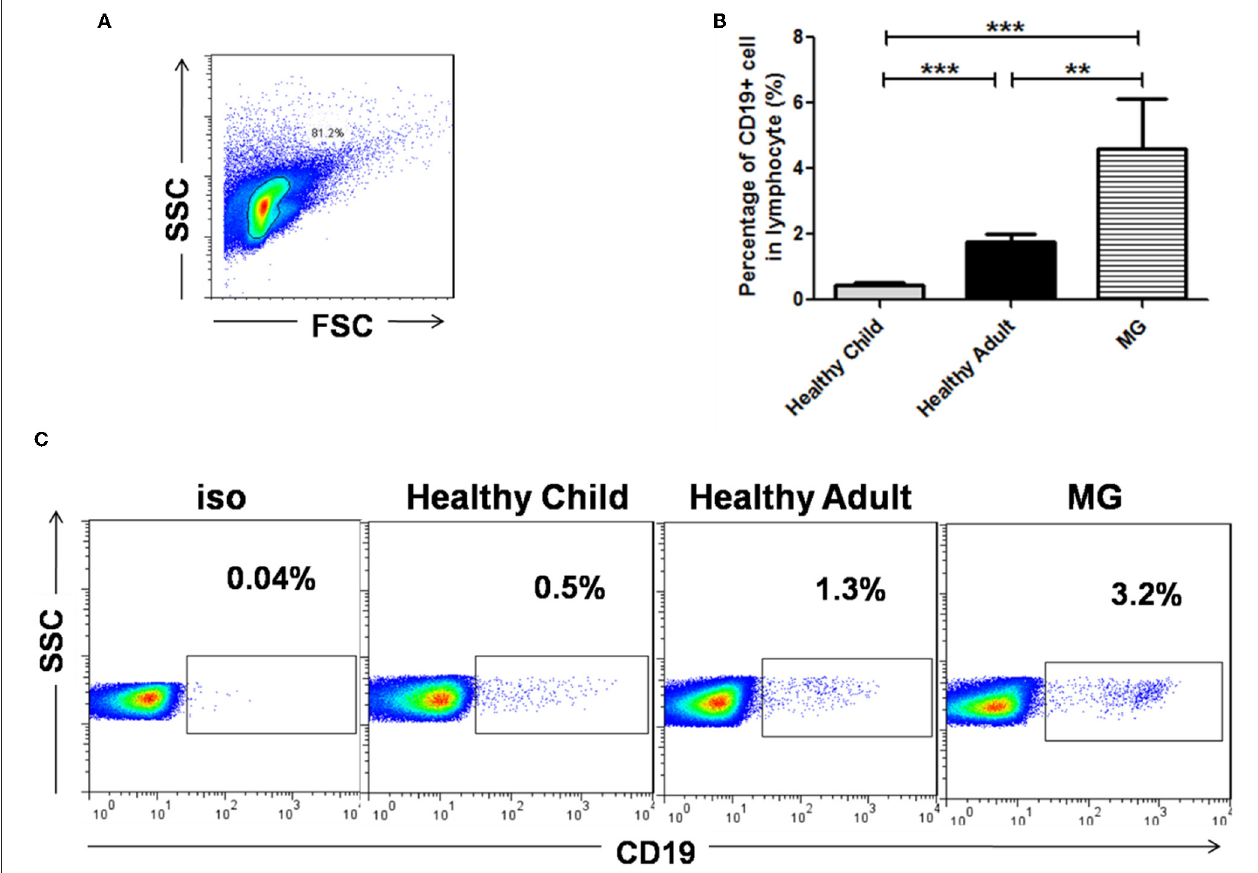
FIGURE 3 | The proportion of CD19 + B cells in the thymus of MG patients and healthy individuals. (A) Lymphocytes were gated according to forward scatter and side scatter by FCM in the thymus of a healthy individual. (B) Bar charts showing the mean percentage ± SE of B cells in the thymus of 10 healthy children, 4 healthy adults, and 13MG patients; ** p < 0.01, *** p < 0.001. (C) CD19 + B cells in the thymus of a healthy child, a healthy adult, and an MG patient were gated by